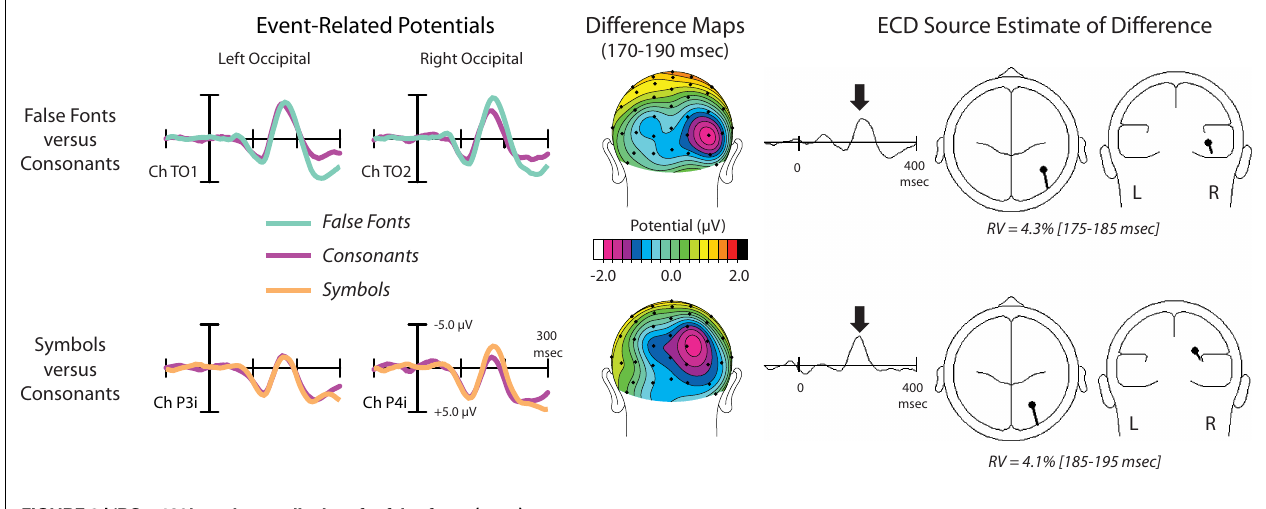
computed between conditions from 170–190 ms are shown from a posterior perspective. Right panels: BESA-computed equivalent current dipole sources for these effects (single-source solutions) and the associated source waveforms are shown on the right, along with the residual variance values for these